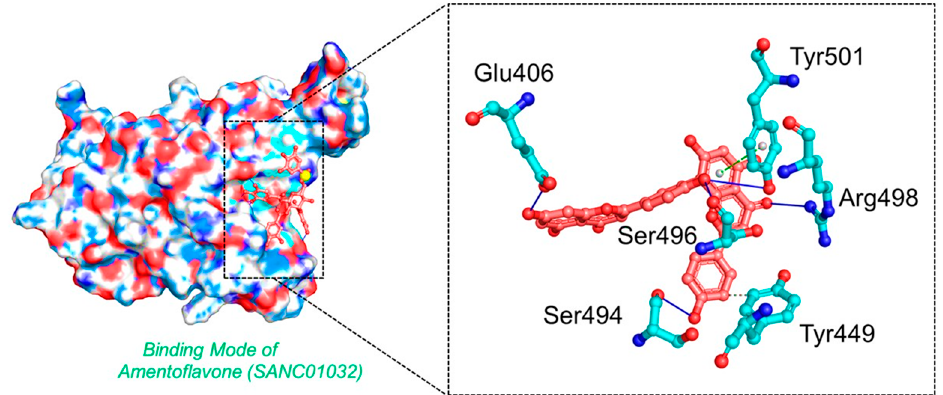
Figure 4. The interaction pattern of Amentoflavone ( SANC01032 ). The left panel shows the surface representation and the binding conformation of Amentoflavone (SANC01032), while the right panel shows the 3-dimensional interaction pattern.